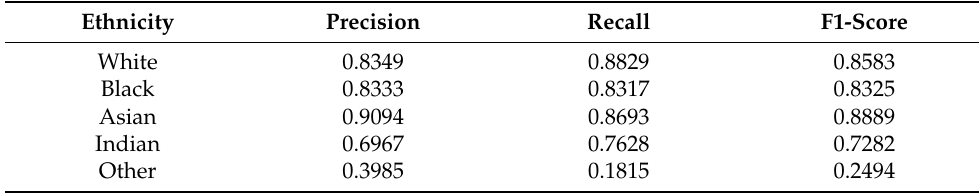
Table 11. Results for the UTKFace filtered testing without plotted landmarks.